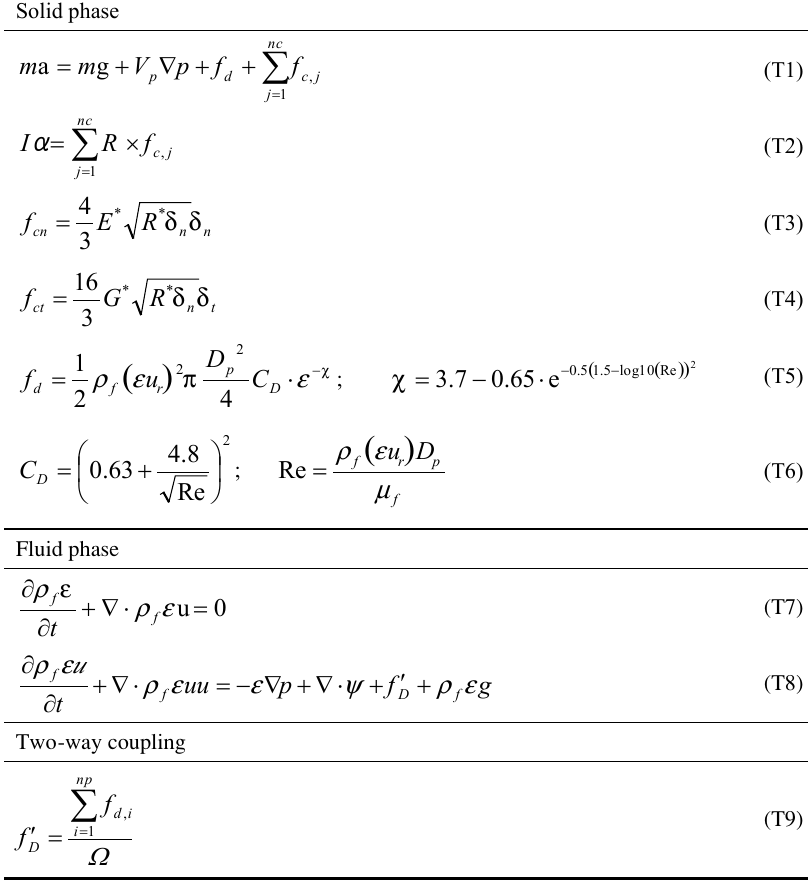
Table 1 Equations used in the DEM-CFD